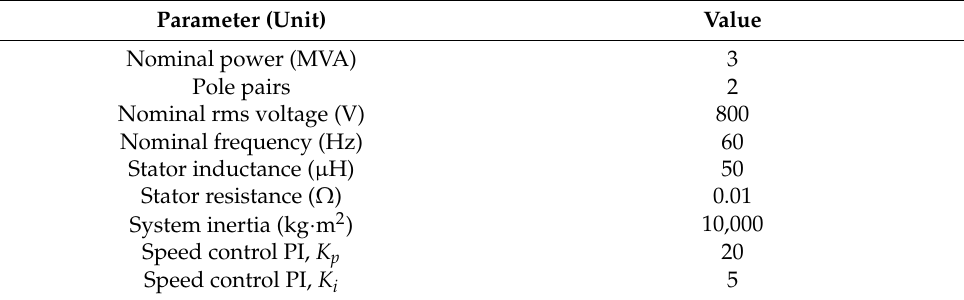
Table 1. Parameters of the diesel generator.